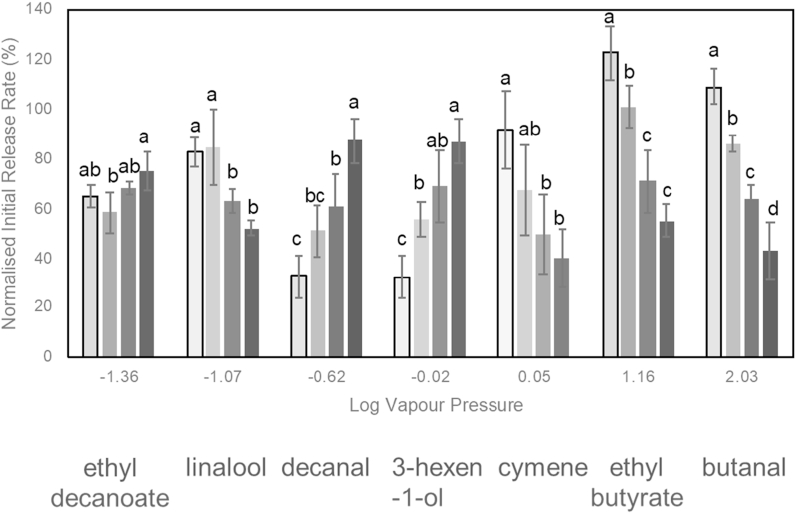
Aroma release rates from phase separated gelatine-starch gels with increased levels of sucrose (light to dark, 0% 20% 40% 60%). Different letters indicate a significant effect (P < 0.05) of sucrose on the release kinetics of that compound.